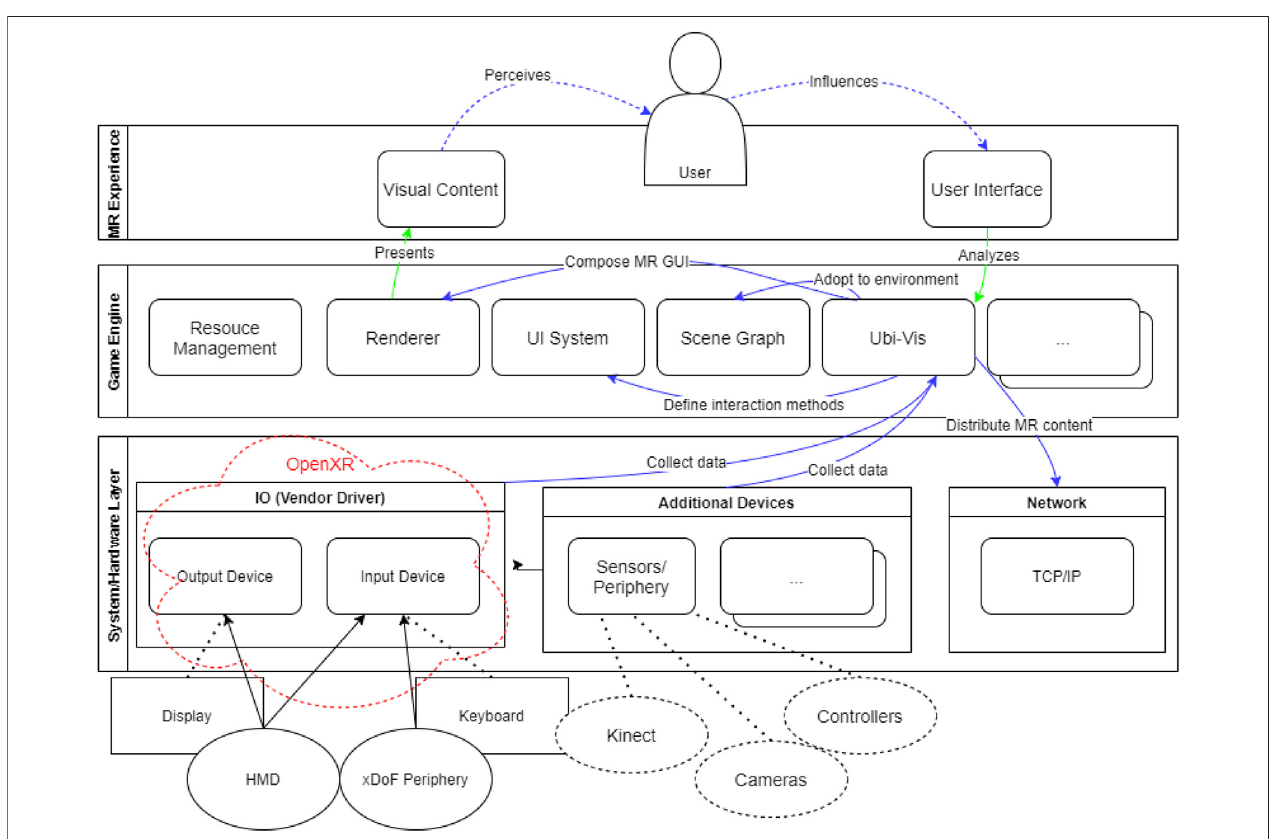
FIGURE 3 | Illustration of the integration of UbiVis in a traditional game engine.